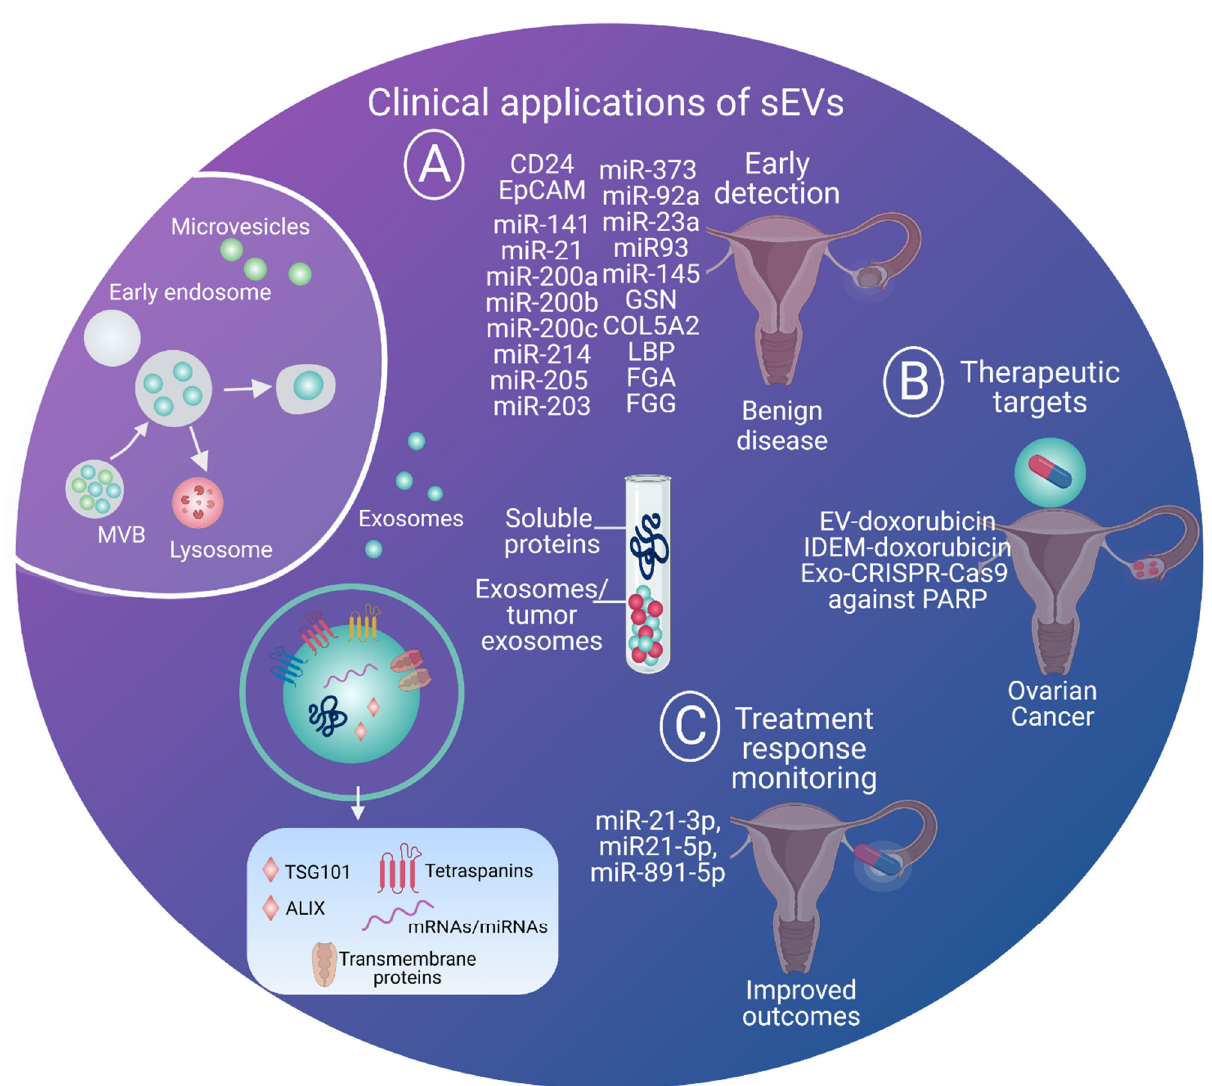
Figure 3. An overview of various clinical application of EVs. The biogenesis of EVs is a continual process in the body as it progresses through different stages. Through non-invasive processes such as blood collection, EVs, especially sEVs, could be excellent biomarkers. Biological fluids can carry not only soluble proteins, but also cancer sEVs, which may contain important information to track the disease. These sEVs can be versatile and may aid in early detection when the benign disease turns malignant. They can also be used as a delivery vehicle for targeted therapies due to their size. Over time, the exosomal biomarkers can be used to predict treatment response as well as monitoring. ( A ) Early detection [44,132,137–141]; ( B ) Therapeutic targets [149–152]; ( C ) Treatment response monitoring [69]. Created with